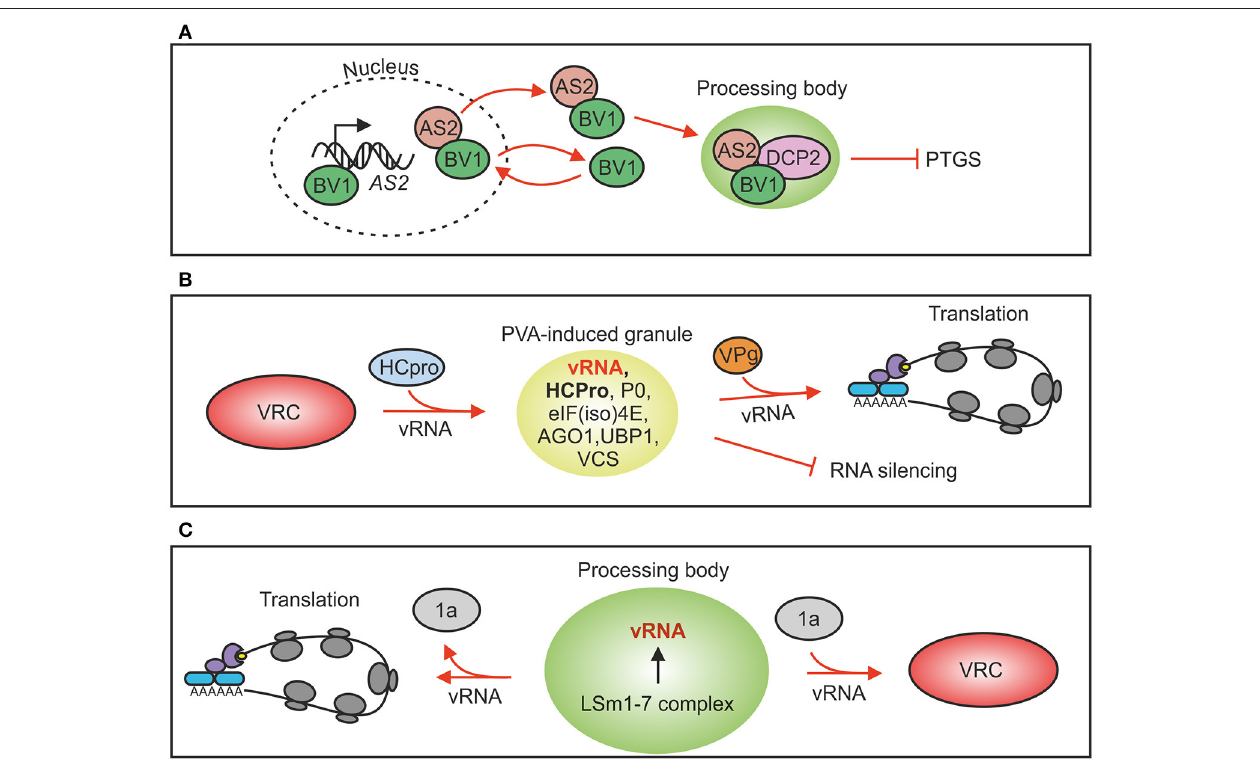
FIGURE 2 | Plant virus interactions with RNP granules. (A) Cabbage leaf curl virus nuclear-cytosol shuttle protein BV1 can bind to the promoter region of AS2 gene and induce its expression. AS2 is transported with BV1 to PBs where it activates DCP2-mediated decapping. Increased RNA decay down-regulates RNA silencing and consequently virus infection gets advantage. (B) Potato virus A silencing suppressor protein HCPro induces formation of RNP granules that contain viral RNA, ribosomal protein P0 and several PB and SG markers. Viral protein genome-linked, VPg, abolishes PVA-induced granules and increases viral translation. Evidence to support silencing suppression-related PG functions exists. (C) Brome mosaic virus genomic RNAs 2 and 3 contain motifs for binding to the decapping activator LSm1-7 complex in PBs of yeast. This interaction is required both for brome mosaic virus translation and replication. In the absence of viral protein 1a vRNA is subjected to translation whereas in its presence vRNA is recruited to replication.